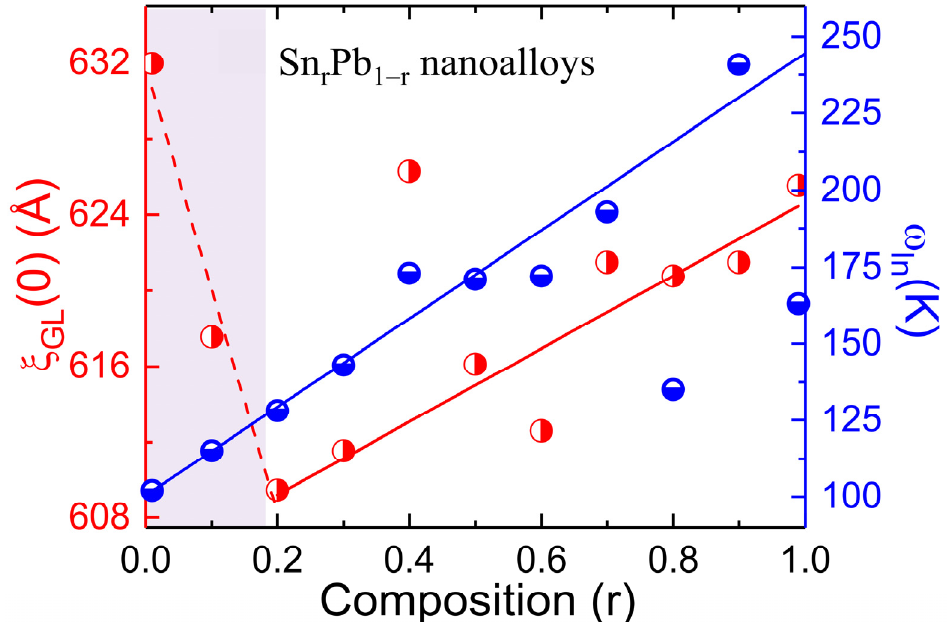
Figure 9. The plot of composition r depends on the GL coherence length and the phonon energy. The red dashed line and solid blue lines are guides for the eyes.